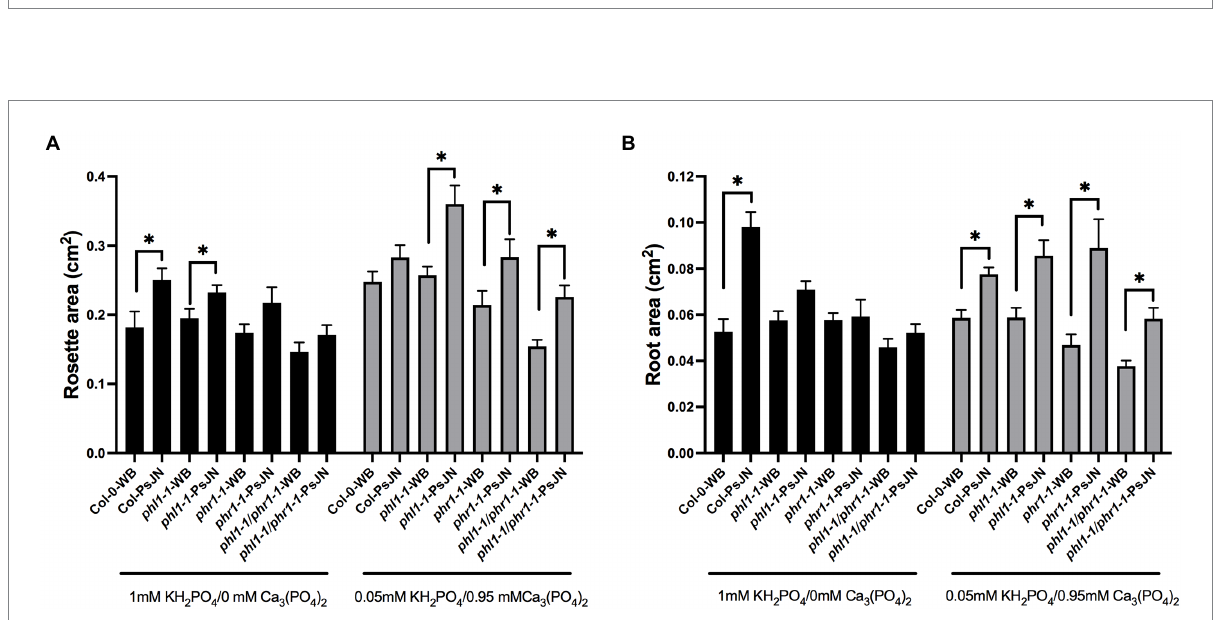
FIGURE 6 Effects of different sources of phosphorus and inoculation with beneficial rhizobacteria in the growth of phr1 and phl1 Arabidopsis thaliana mutants in phosphate starvation response. Rosette (A) and root area (B) in plants 15 days after sowing. Factor 1 consists of different concentrations of KH 2 PO 4 /Ca 3 PO 4 (as phosphate sources with different solubilities). Factor 2 consists of non-inoculated plants (WB) or inoculated with Paraburkholderia phytofirmans PsJN (PsJN). Factor 3 consists of the genotype of Arabidopsis plants (Col-0; the single mutants phl1-1 or phr1-1 and the double mutant phl1/phr1-1 ). Asterisks indicate significant differences in paired comparison for each genotype (WB versus PsJN inoculation) according to a non-parametric Mann-Whitney test ( * p < 0.05).